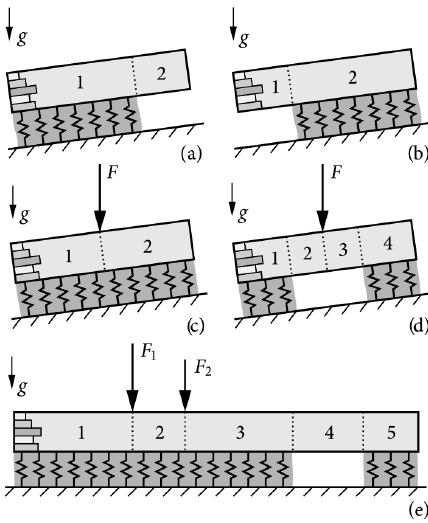
Figure 4. Exemplary systems of interest assembled from supported and unsupported layered slabs with numbered segments: (a) downs- lope PST, (b) upslope PST, (c) skier-loaded snowpack, (d) par- tially fractured weak-layer, and (d) layered slab loaded by multi- ple skiers with partially fractured weak layer. Dotted lines indicate transmission conditions for the continuity of displacements and sec- tion forces.